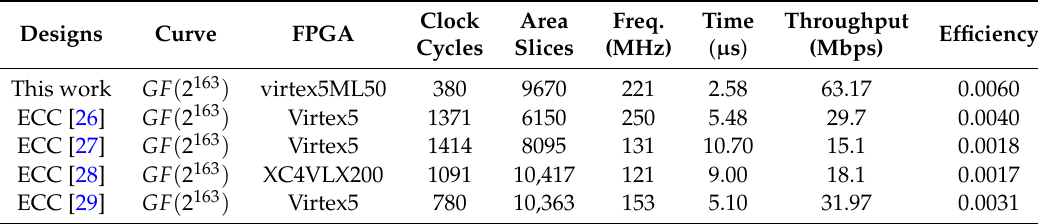
Table 3. ECC Implementation results comparison.